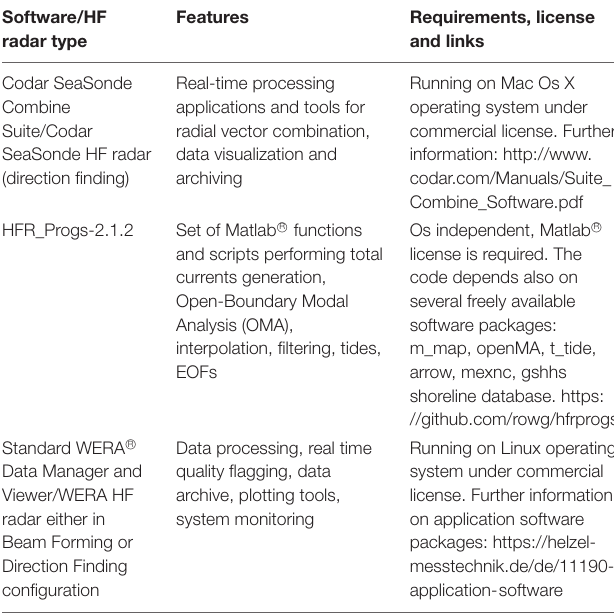
TABLE 9 | Standard software for data